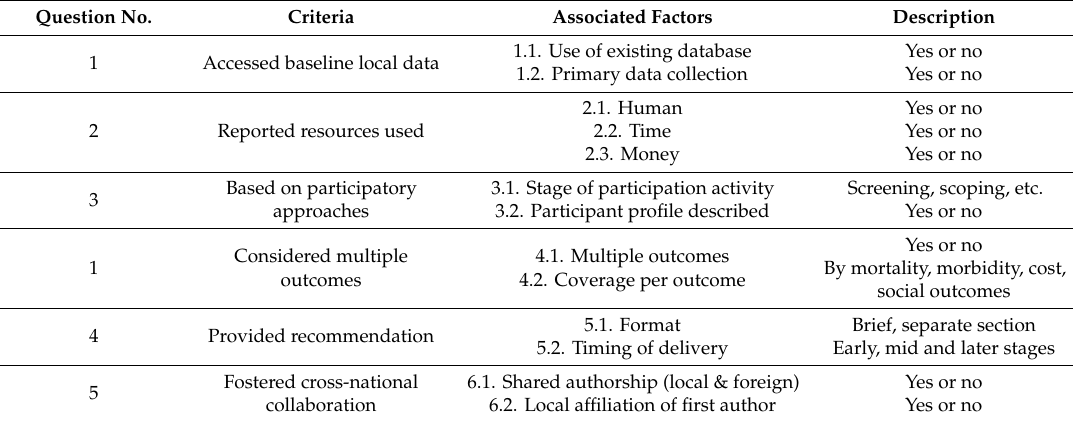
Table 1. Criteria and associated factors for process evaluation.